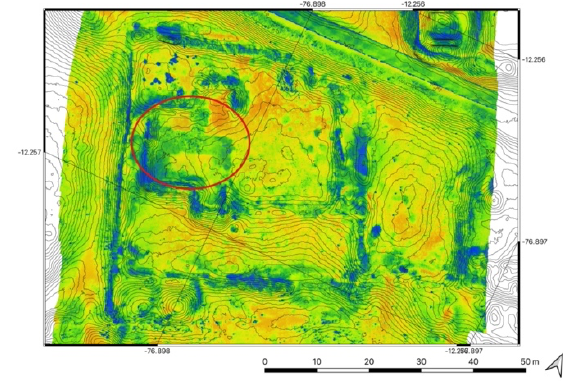
Figure 18 . Crossed results of the various surveys of zone B4 with highlighting of previous excavations